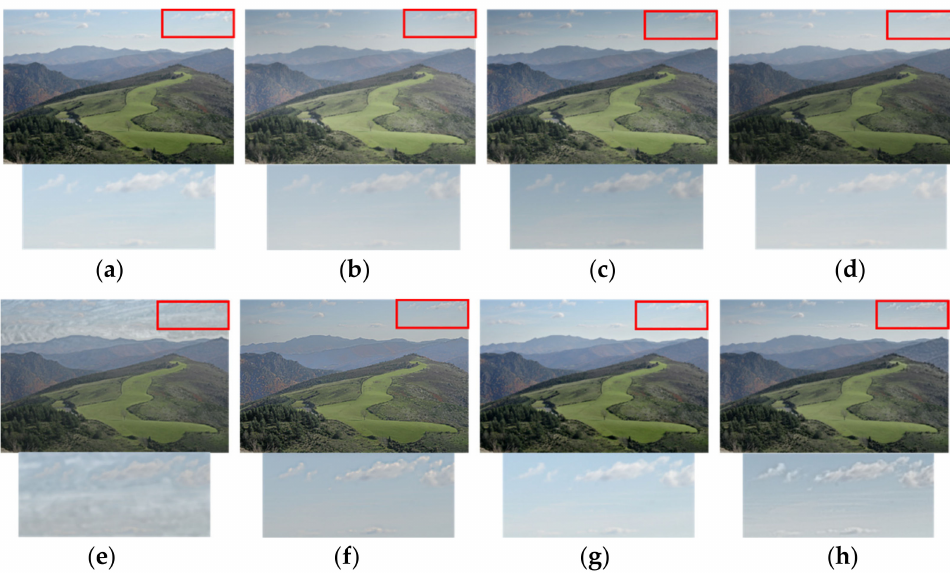
Figure 11. Comparison of fusion results for Figure 9b. ( a ) SPD-MEF method fusion result. ( b ) MRF method fusion result. ( c ) DSIFT method fusion result. ( d ) FEAF method fusion result. ( e ) LE method fusion result. ( f ) B-LP method fusion result. ( g ) LLF method fusion result. ( h ) The proposed